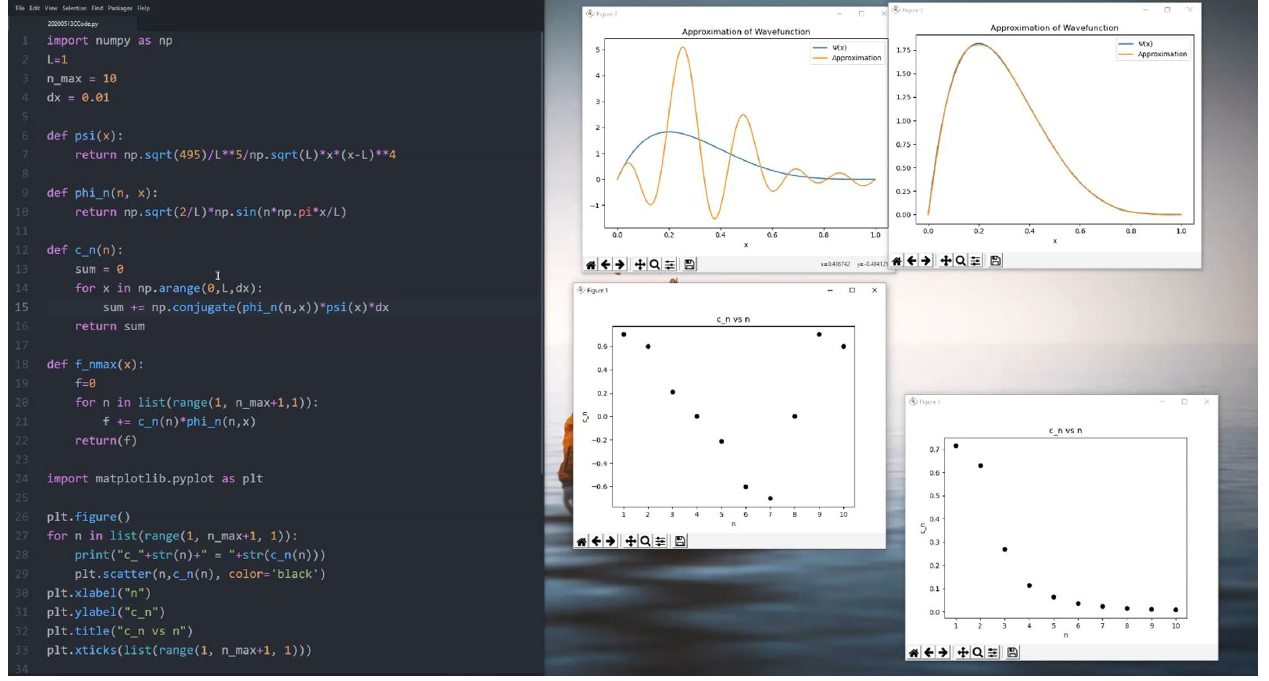
FIG. 2. An image of the screen of the interviewer ’ s desktop where participant C arranged the windows to make comparisons between plots. On the left-hand side of the image is the code participants used during the code manipulation task. The top plots display the wave function (blue) and wave function approximation (orange) with probability density on the vertical axis and position on the horizontal axis. The bottom plots display c n on the vertical axis and n on the horizontal axis. The plots on the left have dx set to 0.25 (the initial value) and the plots on the right have dx set to